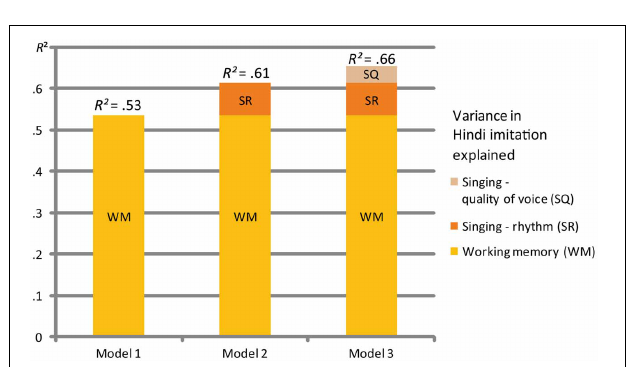
FIGURE 2 | Multiple regression MLR 1. This figure shows the three models explaining the variance in the speech imitation ability of the participants. WM = working memory test, SA = singing ability, and E = Education score.